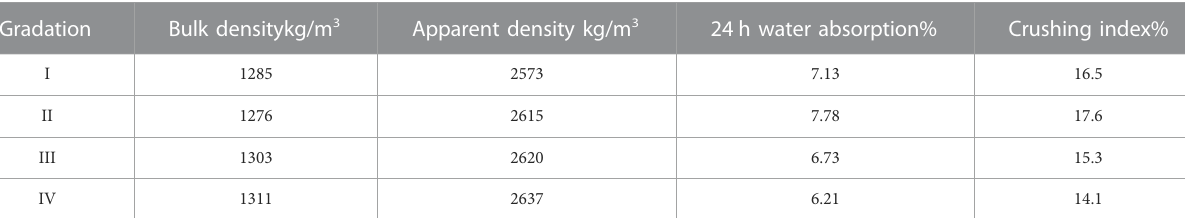
TABLE 2 Physical properties of RCA with different gradations.